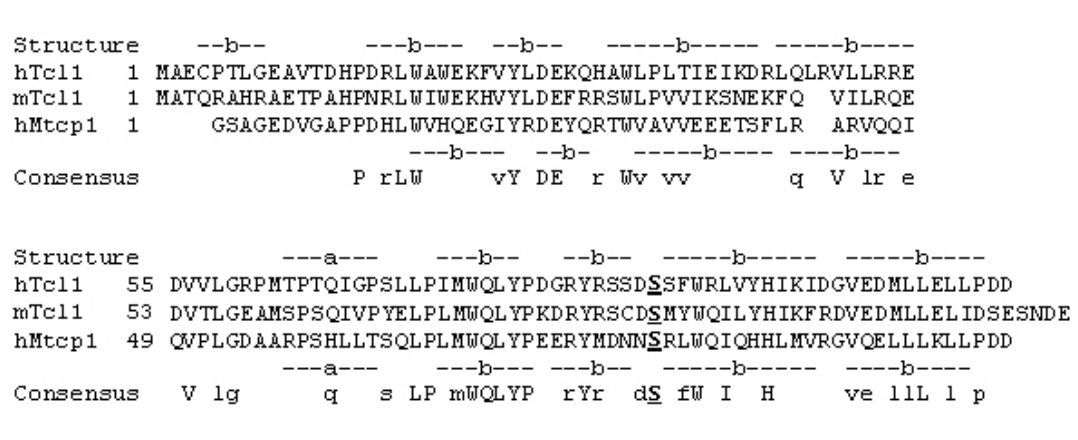
FIGURE 1. Sequence alignment of Tcl1 and Mtcp1 proteins. Sequences are shown for human Tcl1 (hTcl1), mouse Tcl1 (mTcl1), and human Mtcp1 (hMtcp1). The elements of secondary structure are shown for human Tcl1 and Mtcp1 with “a” indicating the short helix and “b” for beta strand. The conserved serine (Ser89 in human Tcl1) is shown in